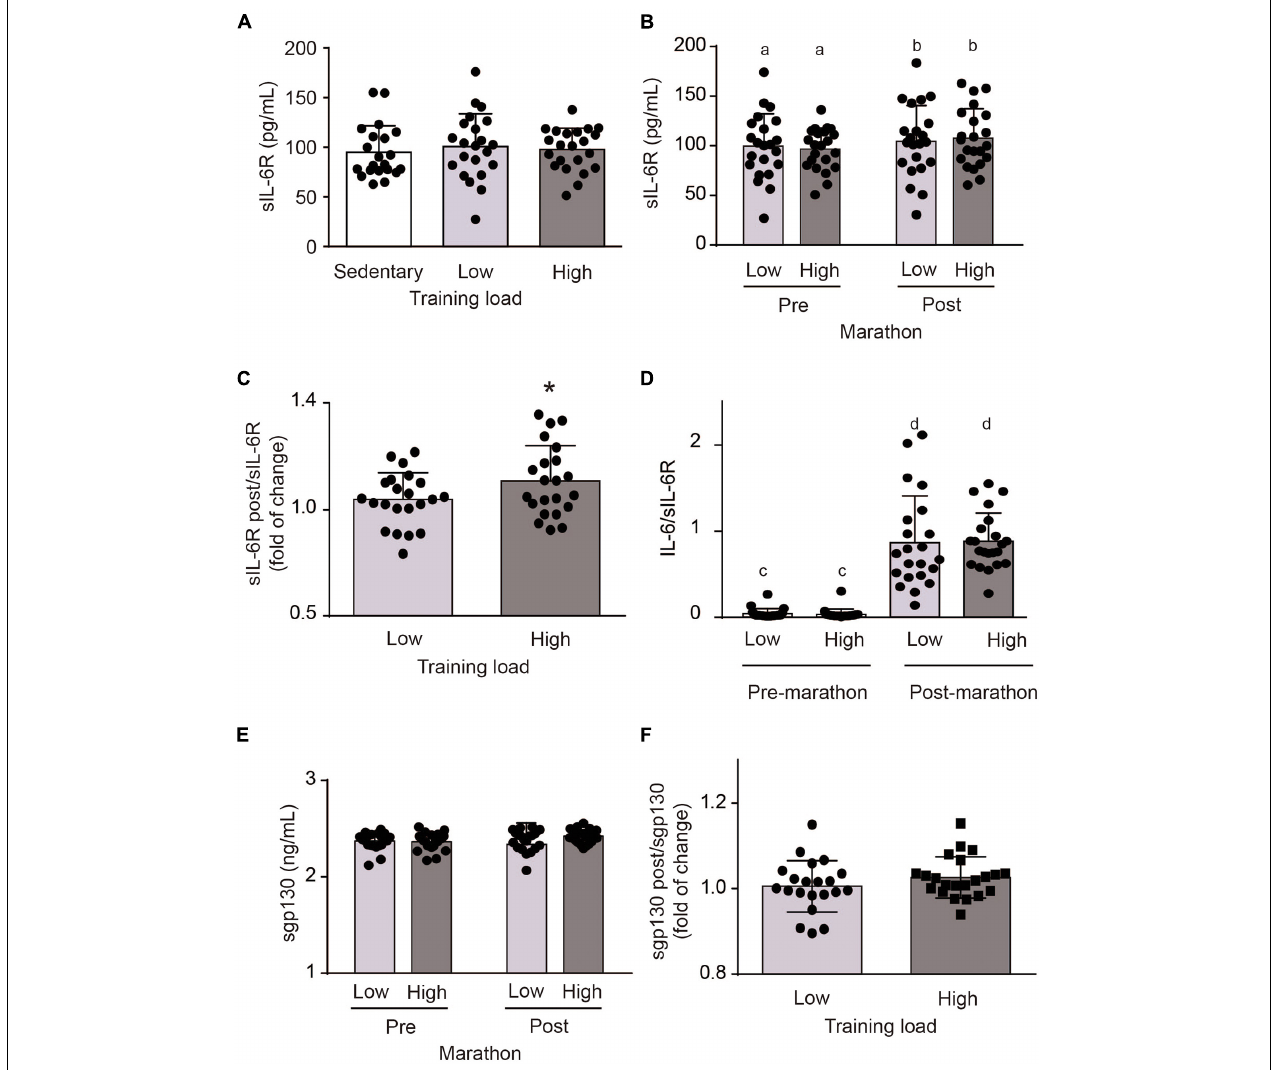
FIGURE 2 | Plasma soluble interleukin-6 receptor (sIL-6R) levels in sedentary subjects and athletes with high (HT) and low (LT) training loads. HT-group: ≥ 100 km by week, n = 22; LT group: < 100 km by week, n = 22; and a healthy and inactive physically group (control, CT; n = 21). (A) Basal venous blood samples were obtained 1 week prior to the marathon. Data were analyzed by one-way ANOVA followed by post hoc Holm-Sidak’s multiple comparisons test. (B) Post-exercise venous blood samples were obtained at the finish line within 5 min of the end of the marathon. Different letters indicate significant differences from different groups at the same time. Data were analyzed by two-way ANOVA followed by post hoc Sidak test; a vs. b p < 0.05. (C) Change in plasma sIL-6R levels. Data were analyzed by Student t -test. * p < 0.05 vs. LT group. Plasma sIL-6R levels were determined using an ELISA kit. (D) IL-6/sIL-6R ratios were calculated. Different letters indicate significant differences from different groups at the same time. Data were analyzed by two-way ANOVA followed by post hoc Sidak test; c vs. d p < 0.0001. (E) spg130 was determined in the same plasma samples obtained prior to and immediately after the marathon using an ELISA kit. Data were analyzed by two-way ANOVA followed by post hoc Sidak test. (F) Change in plasma sgp130 levels. Data were analyzed by Student t -test. Data are mean ± SD.